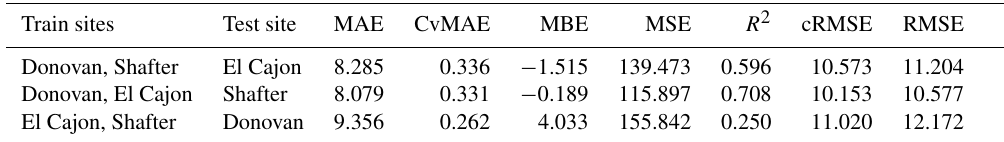
Table D7. Test results for split-NN Level 2, size 3 (O 3 ).